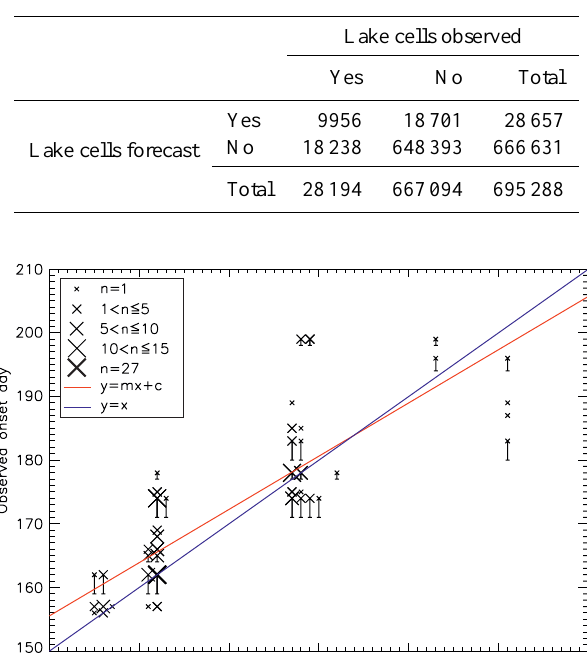
Table 1. Contingency table detailing the number of predicted and observed lake cells in the study area.